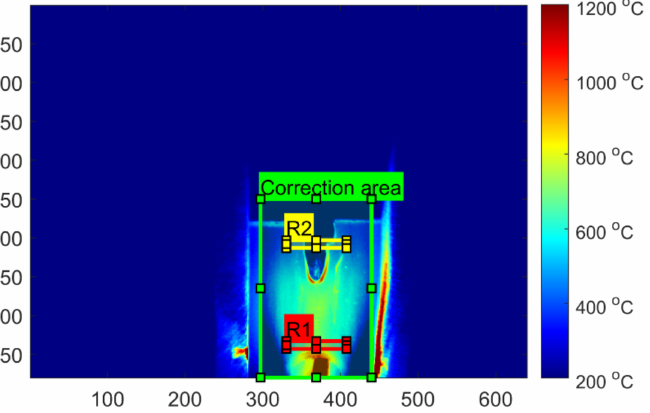
Figure 6. Localization of ROIs (Region of Interest) on an exemplary